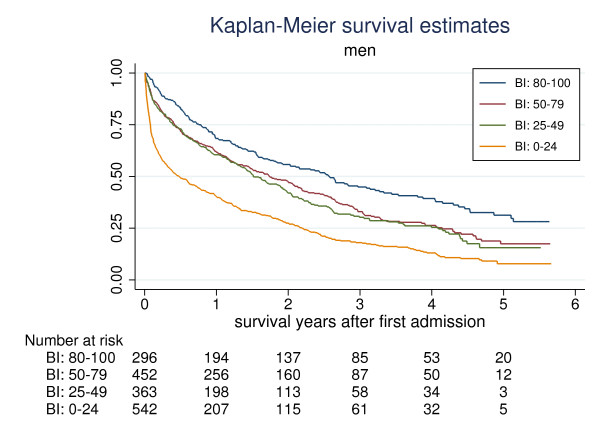
Kaplan-Meier survival estimates in men stratified on Barthel Index (BI) measured at admission. BI: 80-100 (blue), 50-79 (red), 25-49 (green), 0-24 (yellow)